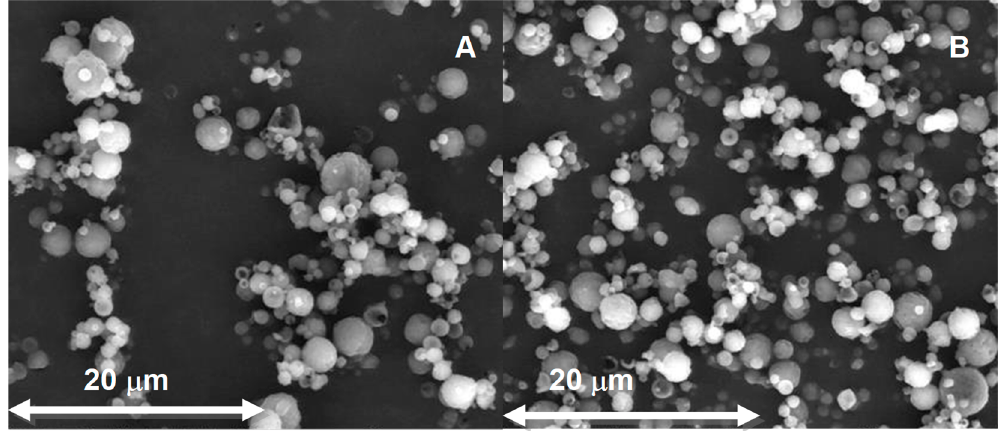
Figure 3. ( A ) SEM images of the surface of proliposome powders without xanthone 2 produced from the SD method; and ( B ) SEM images of the surface of proliposome powders with xanthone 2 produced from the SD method.